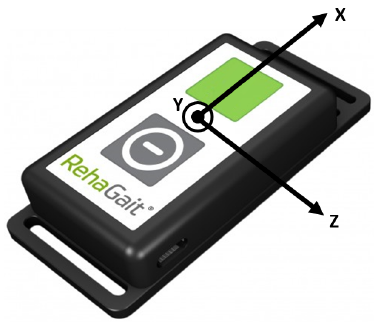
Figure 5. Local coordinate system of an IMU .